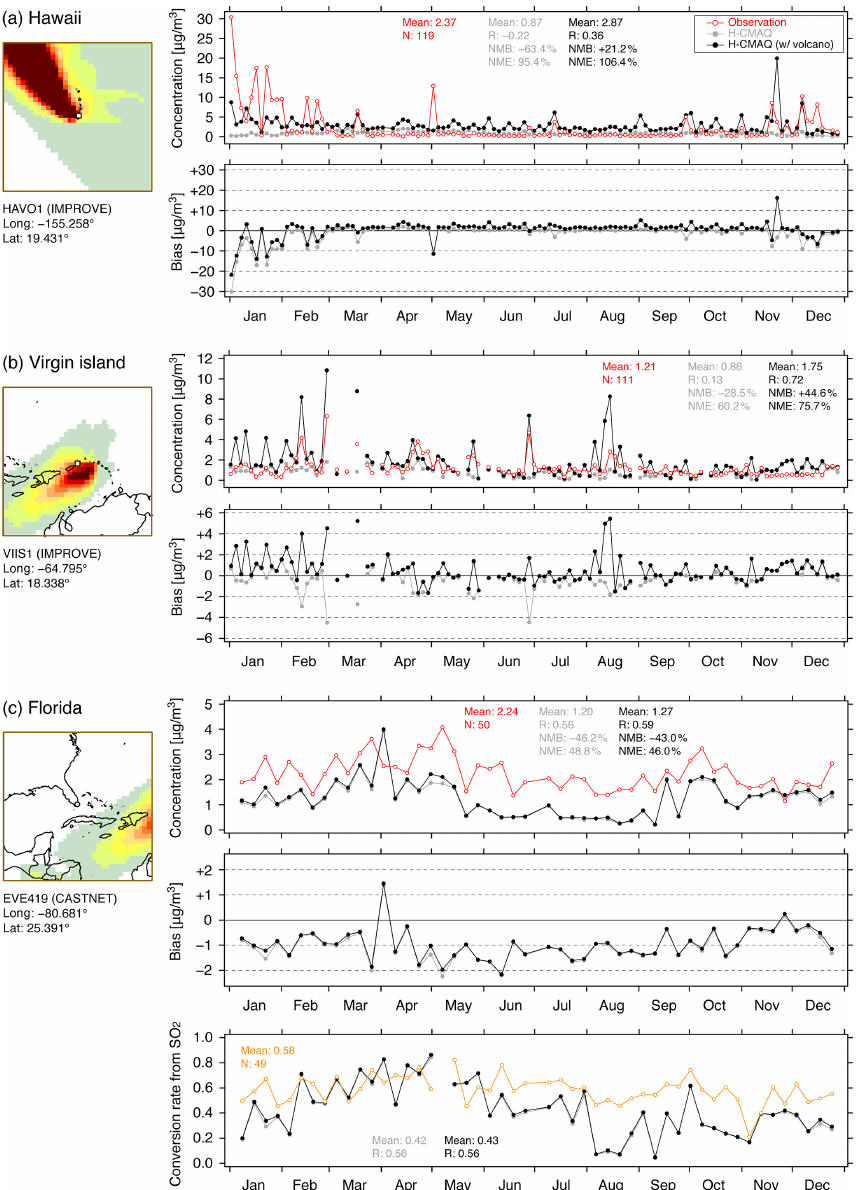
Figure 6. Temporal variation of observed and simulated SO 2 − concentrations and simulation biases at (a) Hawaii IMPROVE site (HAVO1), 4 (b) Virgin Islands IMPROVE site (VIIS1), and (c) Florida CASTNET site (EVE419) in 2010. Red open circle denotes observations, and gray and black closed circles denote original H-CMAQ and H-CMAQ incorporating volcanoes, respectively. Statistical scores are indicated in the inset. The comparison of conversion rate from SO 2 to SO 2 − is also shown in (c) 4